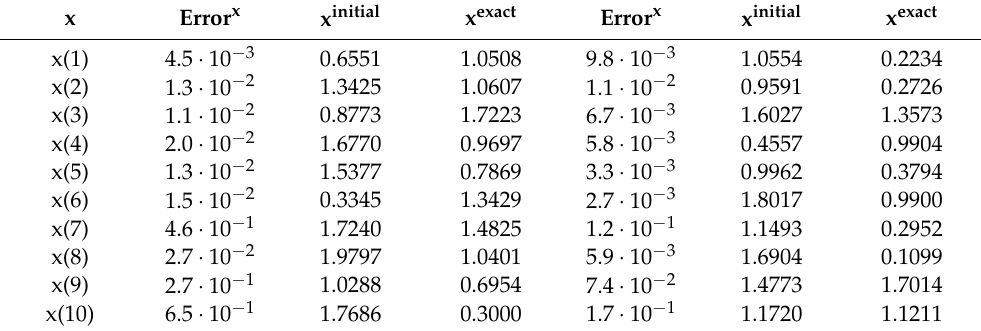
Table 3. The optimization method applied to two representative cases, considered in columns 2–4 and 5–7. In both cases, the error in the degradation parameters is given in the second and fifth columns. Since these errors are fairly small in both cases, only the initial condition and the exact degradations are displayed.